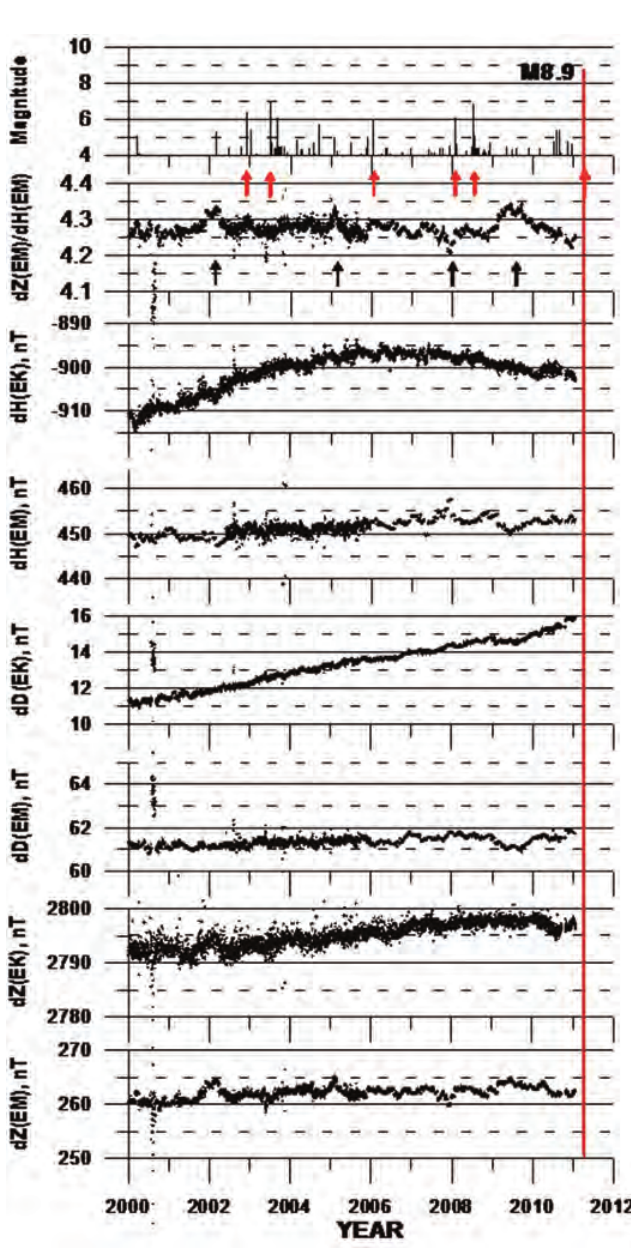
Figure 3. Magnitudes (M ≥ 4) of earthquakes (top panel) during the period of January 1, 2000 to January 31, 2011. The differences (dH, dD, dZ) of the corresponding magnetic components of pairs of remote magnetic stations (Esashi-Mizusawa – EM and Esashi-Kakioka – EK) (six lower curves). Ratio dZ/dH for the Esashi and Mizusawa magnetic stations (second from top). Black arrows mark moments of the anomalies, and red arrows indicate the moments of seismic shocks with M ≥